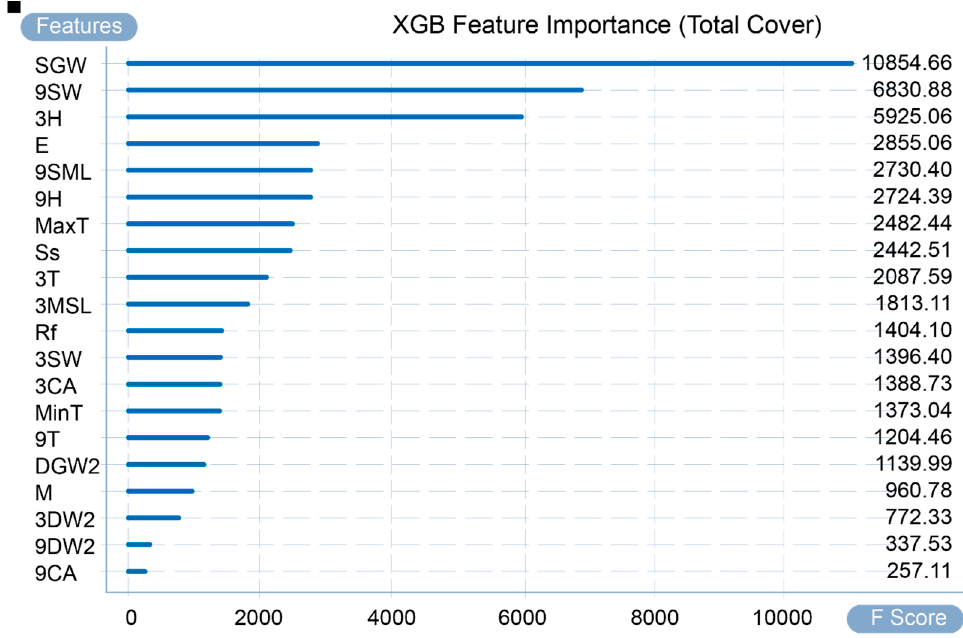
Figure 9. Feature importance for total coverage.